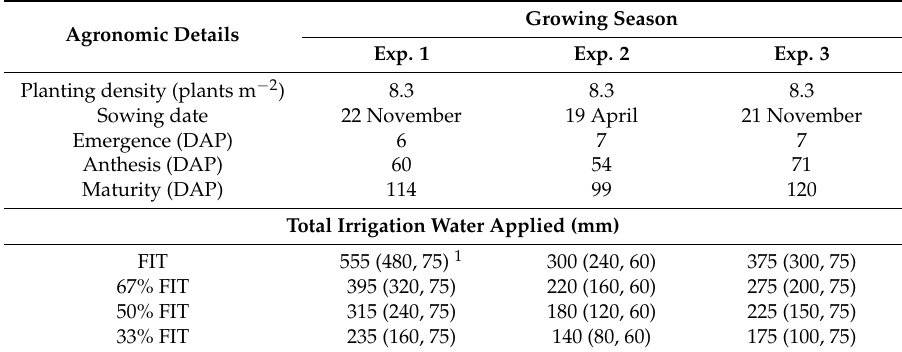
Table 2. Timeline of main phenological growth stages in days after planting (DAP) and seasonal water applied for the different treatments for the three experiments